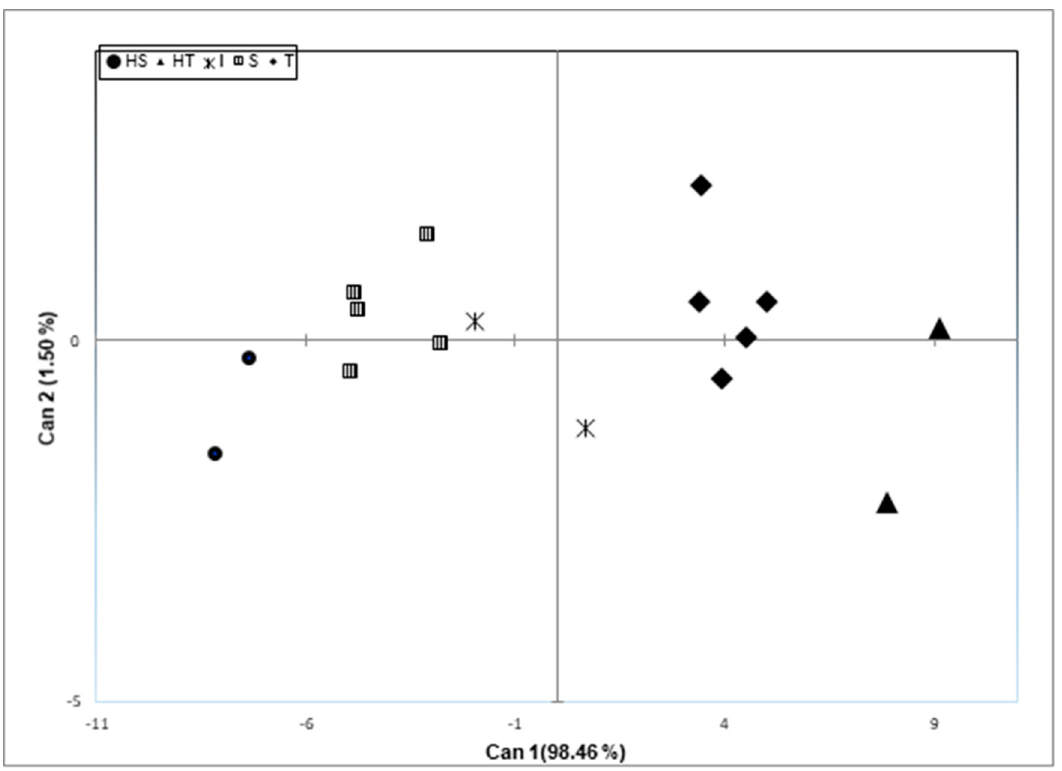
Figure 6. Distribution of 16 wheat genotypes by discriminant analysis of shoot length (SL), catalase (CAT), and shoot dry weight (RDW) traits responses to salt stress. Highly tolerant (HT), tolerant (T), intermediate (I), sensitive (S), and highly sensitive (HS).